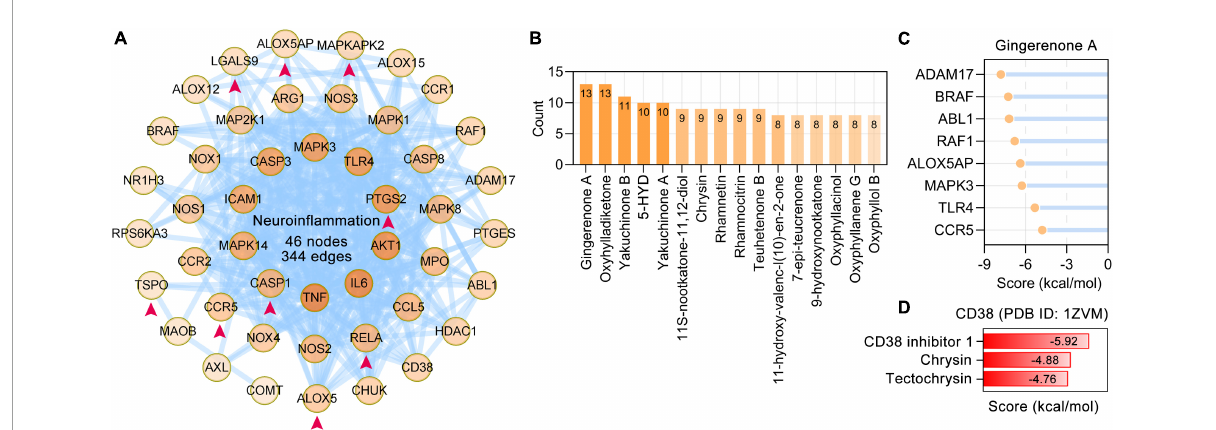
FIGURE7 Alpinia oxyphylla Miquel (AO) targets and their phytochemicals targeting neuroinflammation. (A) The PPI network was constructed for the 47 targets of AO associated with neuroinflammation. AO targets specifically localized to microglia were pointed out by red arrows. The darker the color, the higher the degree. (B) AO phytochemicals involved in neuroinflammation ranked according to the numbers of targets. (C) Molecular docking of gingerenone A with proteins involved in neuroinflammation. (D) Molecular docking of the tectochrysin, chrysin and CD38 inhibitor 1 (compound 78c) with CD38.